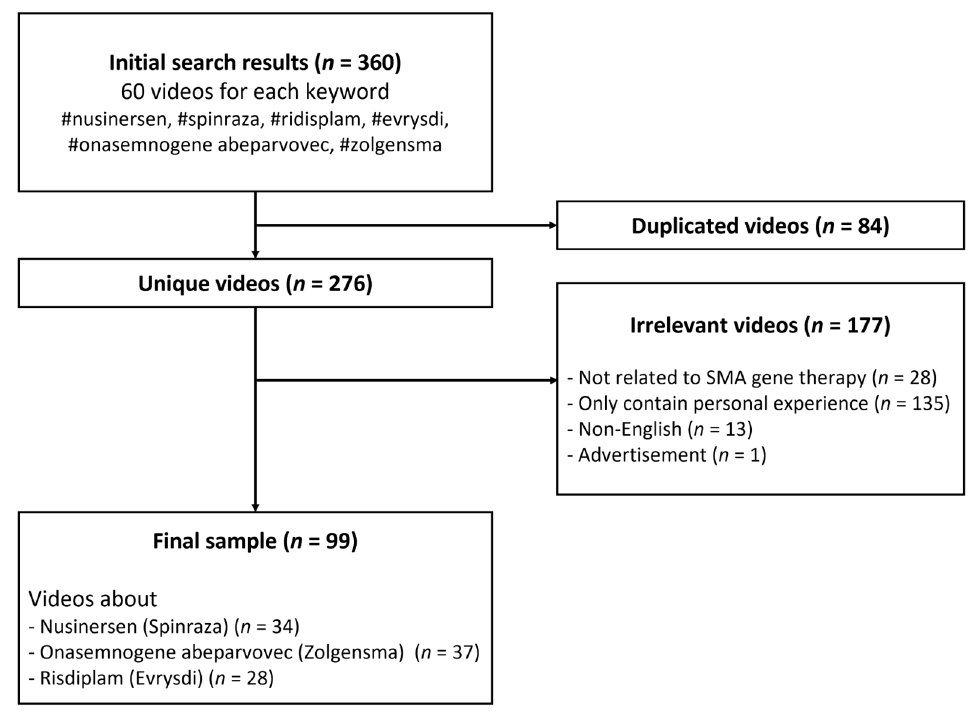
Figure 1. Flowchart of the search process for videos related to gene therapy for SMA.